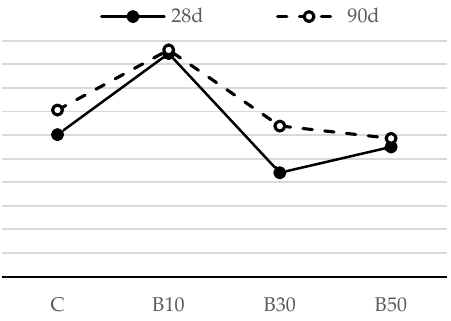
Figure 7. Compressive strength of mortars blended with biomass ash.